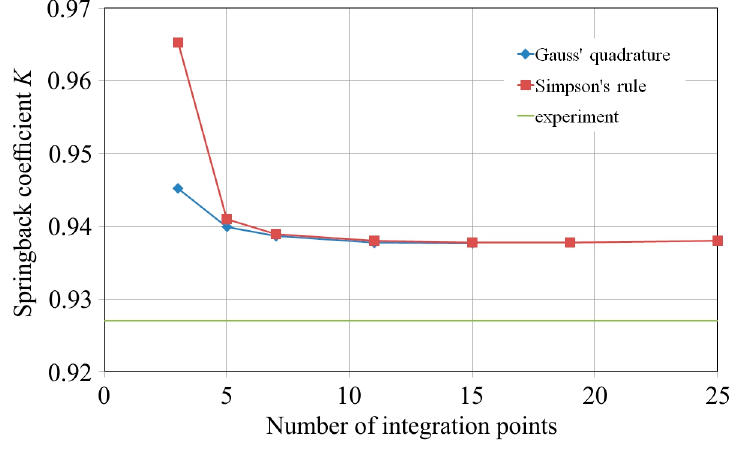
Figure 6. Effect of a number of integration points on the value of the springback coefficient K for Gauss’ quadrature and Simpson’s rule.